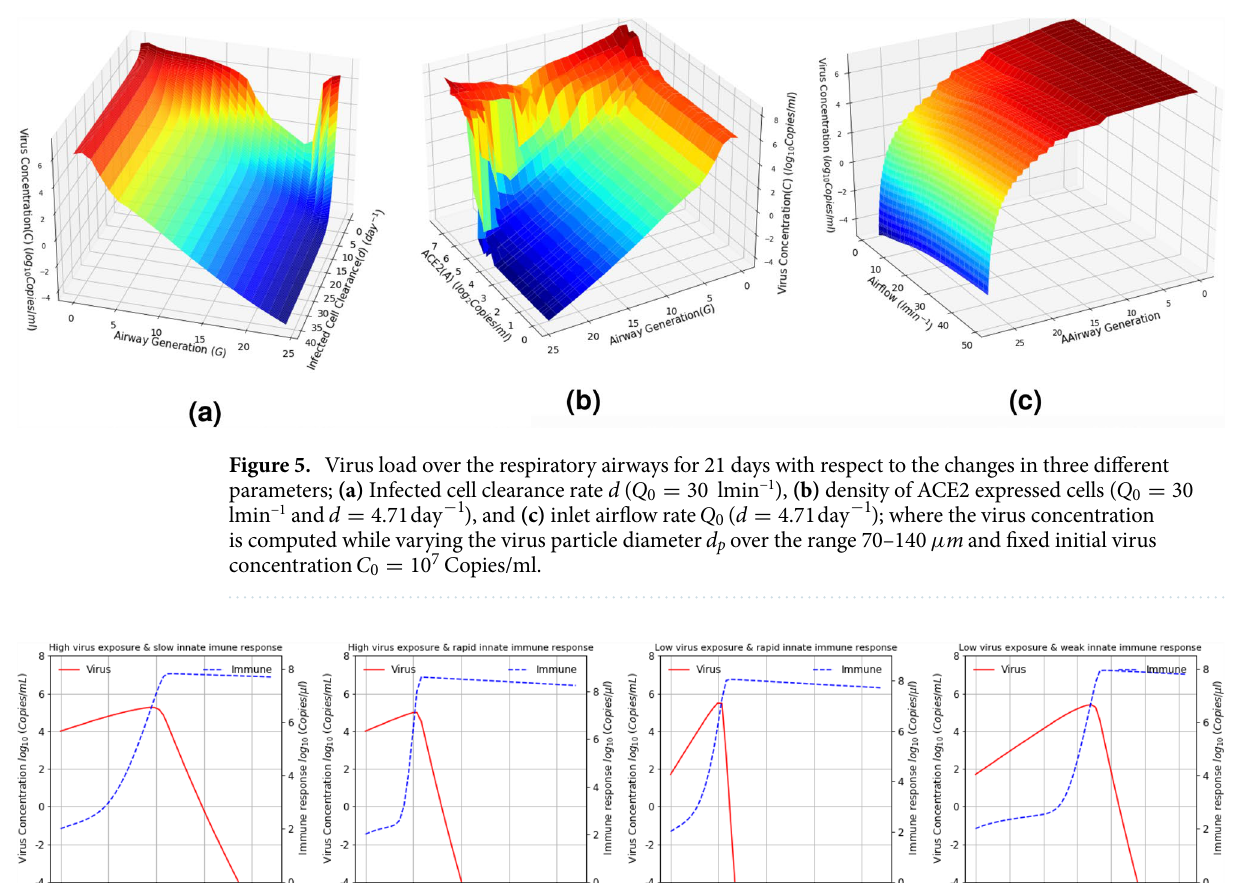
Figure 6. Impact of the immune response and the exposure level on the overall virus load, given that the initial 1 ) ; ( a ) high exposure level 4.71 ( day T-cell level T 0 is 10 3 Copies /µ l and the infected cell clearance rate d − = 10 4 Copies/ml) and slow immune response ( r 10 4 Copies/ .5 day − 1 ) and ( b ) high exposure level ( C 0 ( C 0 = = = 50 Copies/ml) and rapid 10 day − 1 ), ( c ) low exposure level ( C 0 ml) and rapid initial immune response ( r = = 50 Copies/ml) and slow immune 10 day − 1 ), and ( d ) low exposure level ( C 0 initial immune response ( r = = .5 day − 1 response ( r =